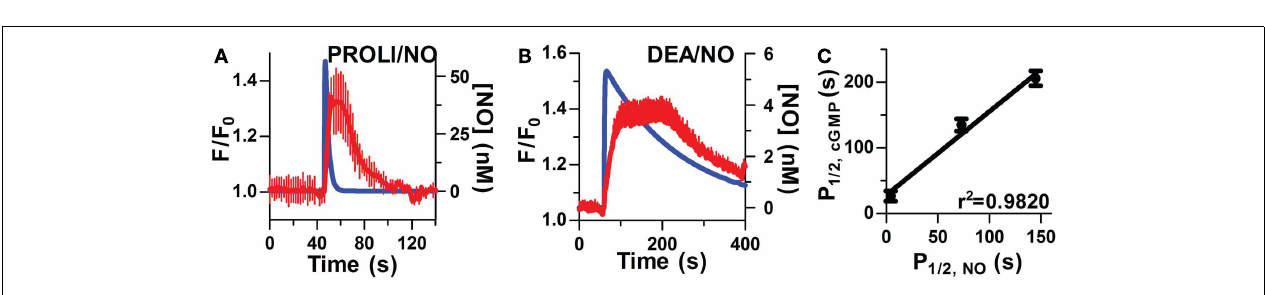
PROLI/NO) and (B ; DEA/NO). (C) Relationship between NO and cGMP transients as measured by P 1/2 (r 2 = 0.9820, p < 0.0001 by one-way